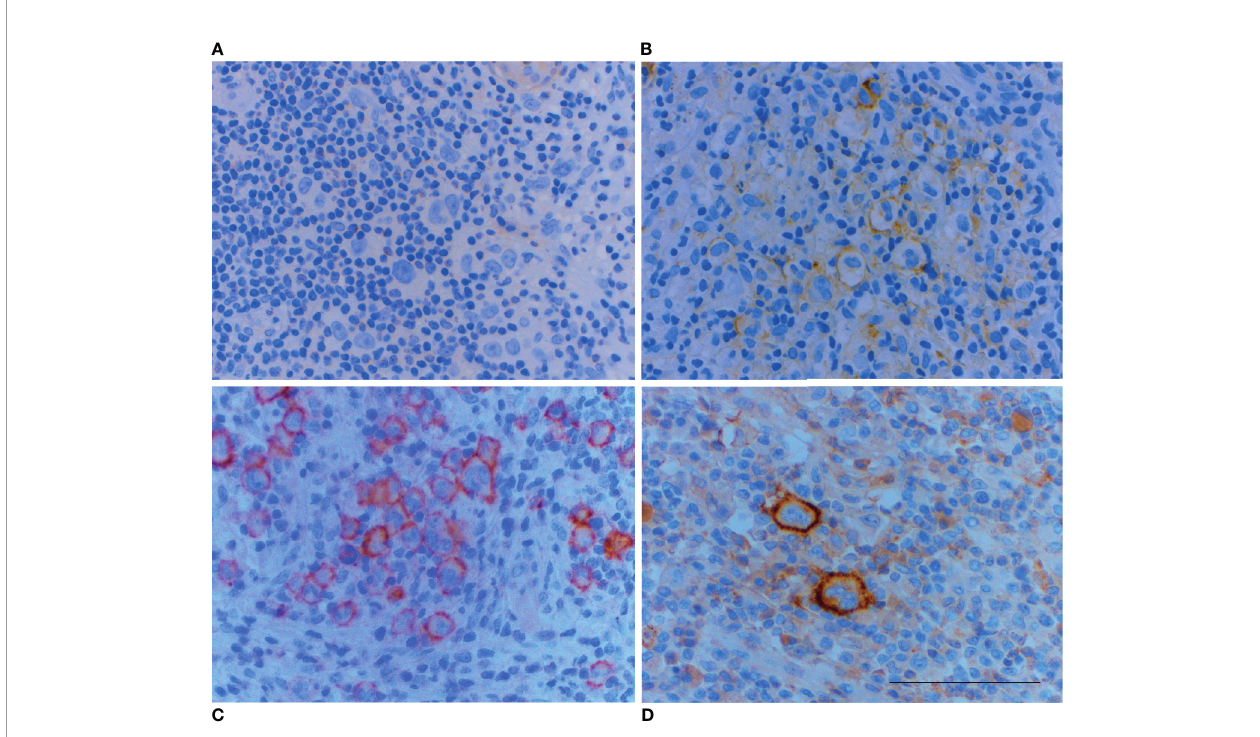
FIGURE 1 | Examples of different staining intensities on the cell membrane of malignant Reed-Sternberg and Hodgkin cells: (A) no staining (score 0), (B) mild staining (score 1), (C) moderate staining (score 2) and (D) strong staining (score 3). Brown color indicates positive staining. Scale bar=100 µm.